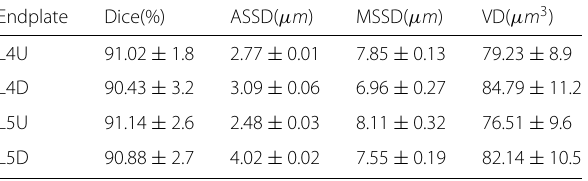
Table 2 Accuracy evaluation of the proposed segmentation method based on VD, Dice, ASSD, and MSSD metrics